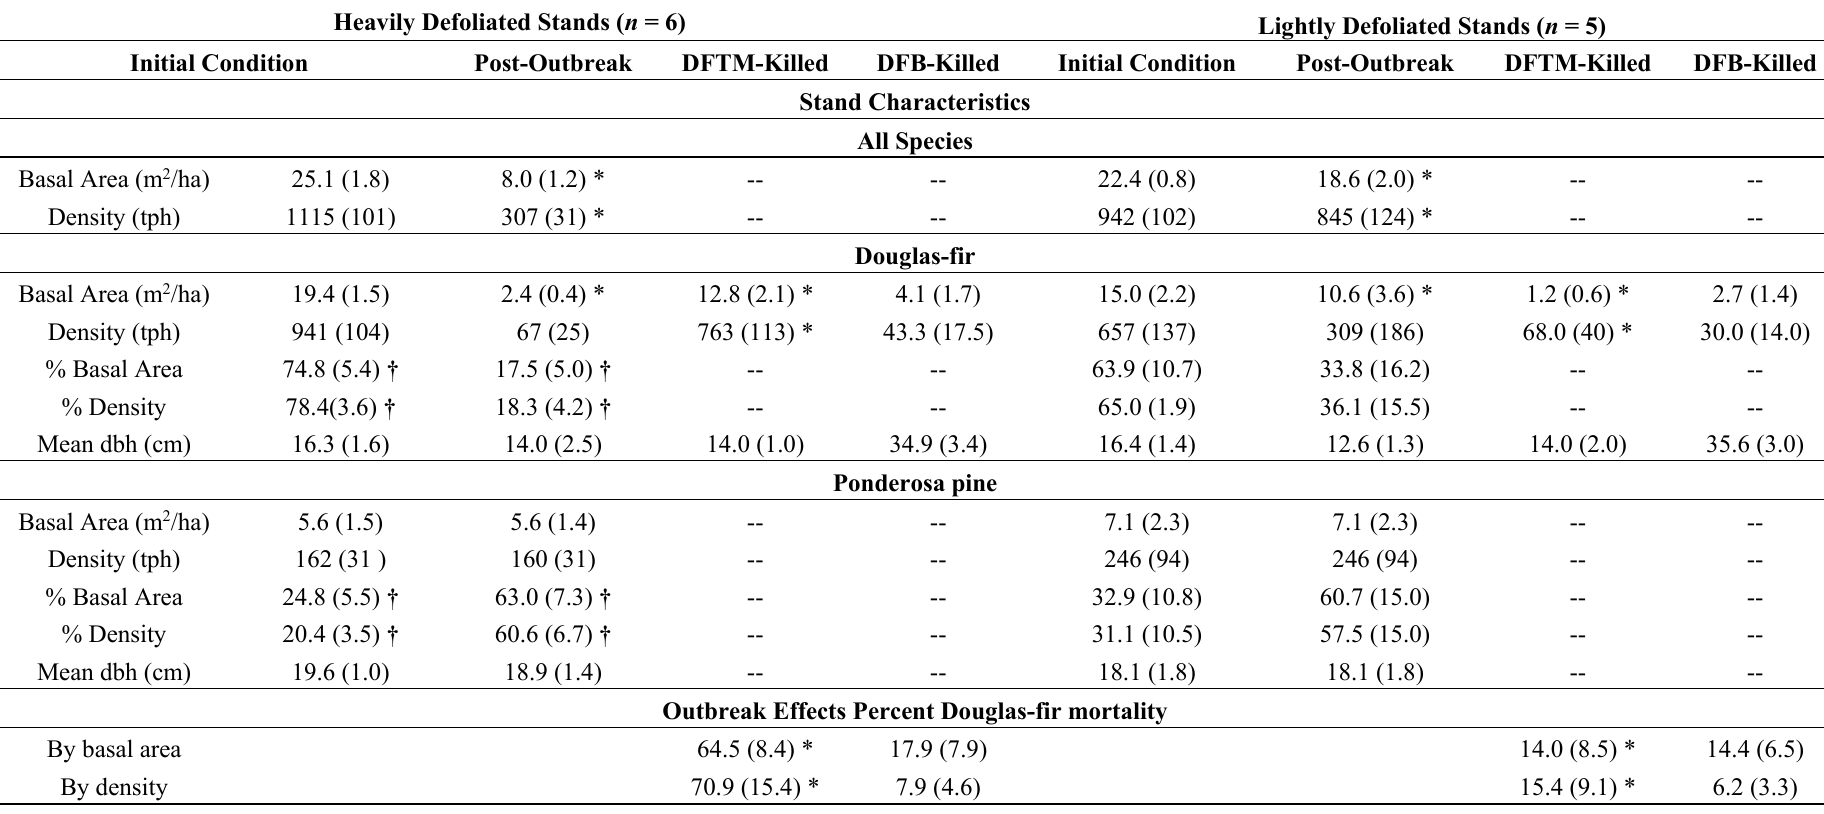
Table 1. Means (±SEM) of density (tph, trees per ha), basal area (m 2 /ha), and diameter at breast height (dbh) of all species combined, Douglas-fir, ponderosa pine, Douglas-fir tussock moth- and Douglas-fir beetle-related mortality (DFTM and DFB, respectively) of heavily and lightly defoliated stands in the study area. Asterisks (*) indicate values that are significantly different ( p < 0.05) for the same variable between heavily and lightly infested stands in the same line (PROC GLIMMIX, SAS), and daggers ( † ) indicate values of initial condition and post-outbreak that are significantly different ( p < 0.05) for the same variable in adjacent columns, MRPP test. Pike-San Isabel National Forest, Colorado, USA,